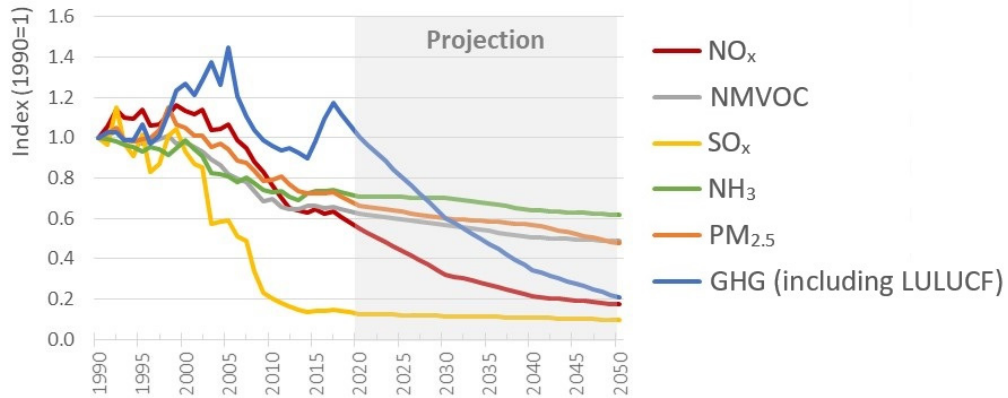
Figure 10. Historic and projected trends of air pollutant and GHG emissions in Portugal (projections for YJ scenario).